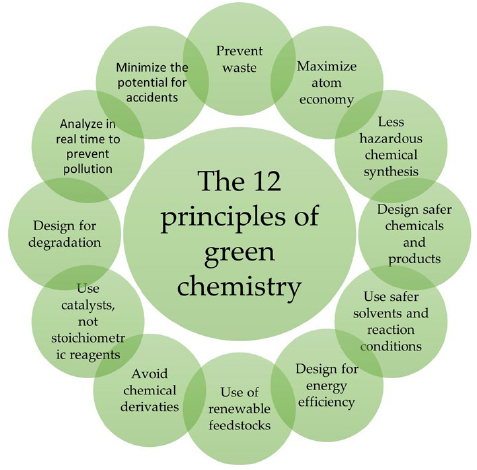
Figure 1. Scheme of the 12 principles of Green Chemistry.